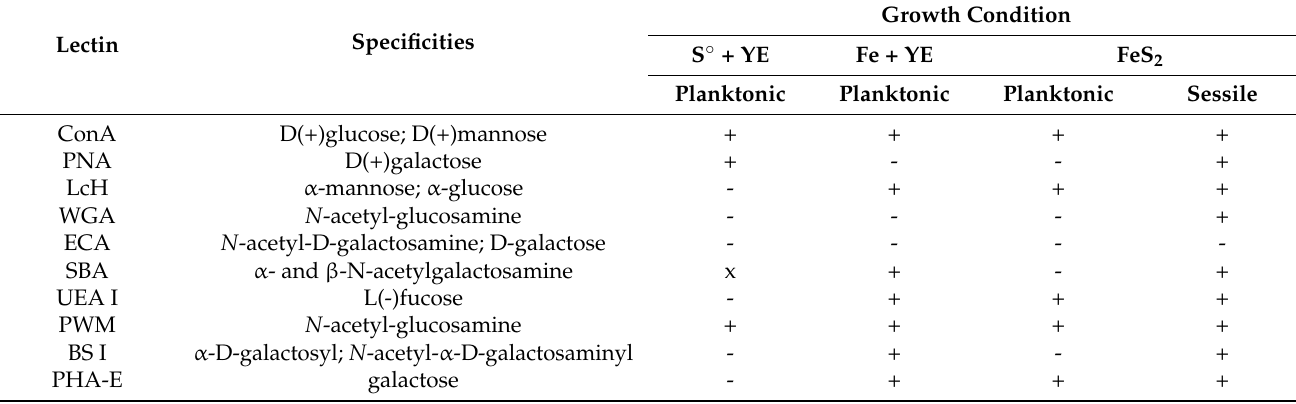
Table 3. Fluorescence lectin binding assays